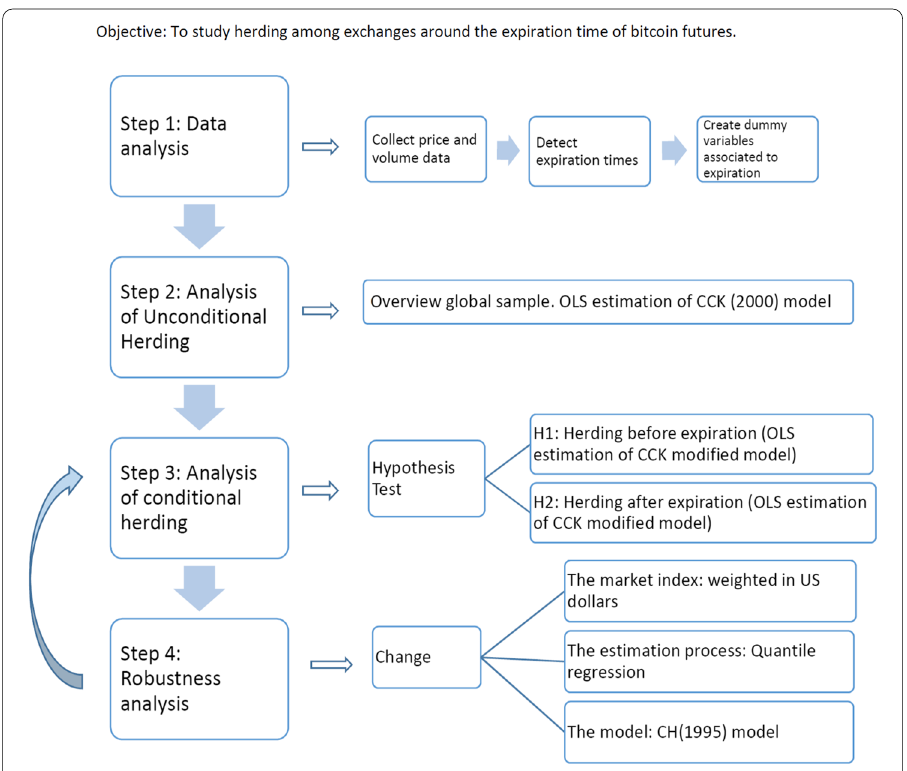
Fig. 1 Flow chart of the analysis